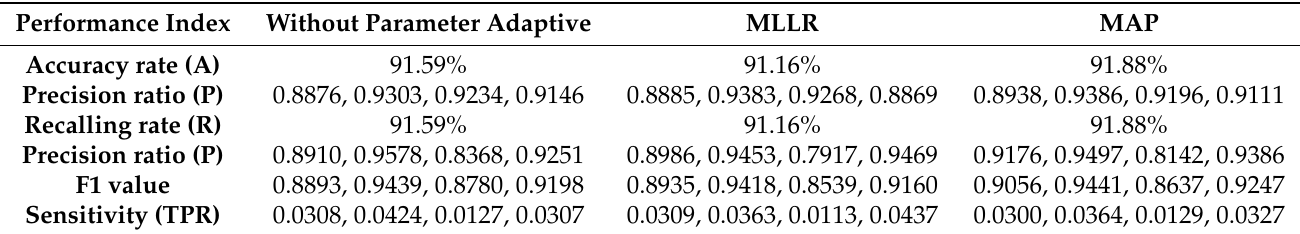
Table 3. Comparison of performance using different methods.